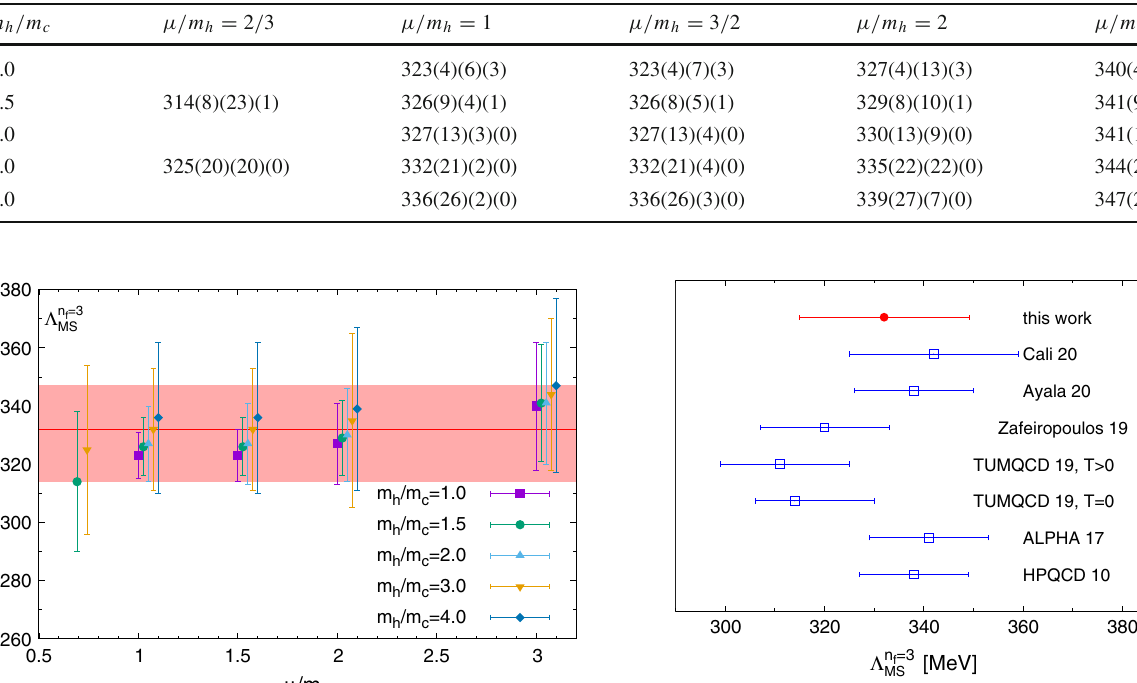
= 3 Table 2 The Λ n f obtained for different values of m h and different choices of the renormalization scale. The first error comes from the lattice MS calculations, the second error is the perturbative error, and the last error is due to the gluon condensate